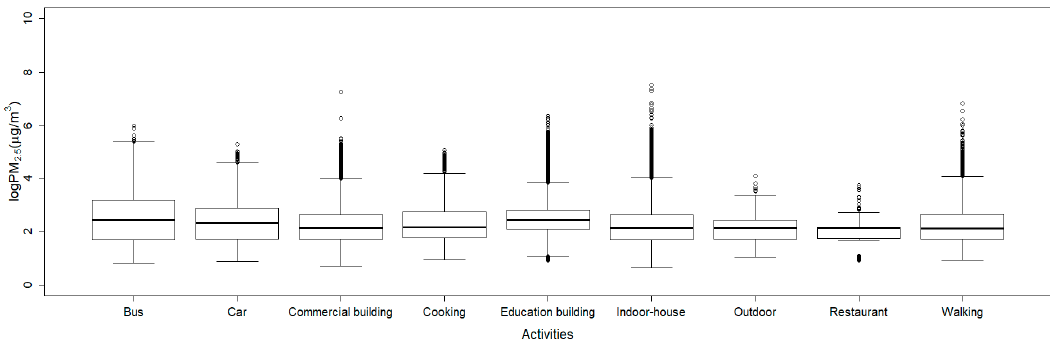
Figure 3. This is a PM 2.5 boxplot drawn in logarithmic scale for each activity patterns for the entire dataset. As shown in the figure, the PM 2.5 concentrations for each activity patterns are quite different statistically, especially in terms of maximum values by eyeballing the figure. We chose the median and the maximum values as features for classification.